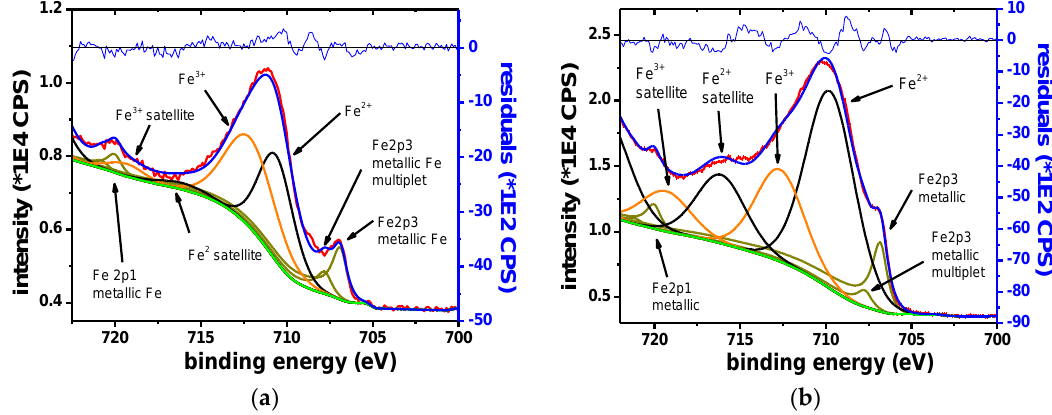
Figure 16. Fe 2p3 narrow scan, initial spectrum ( a ) and spectrum after 15 s of etching ( b ).